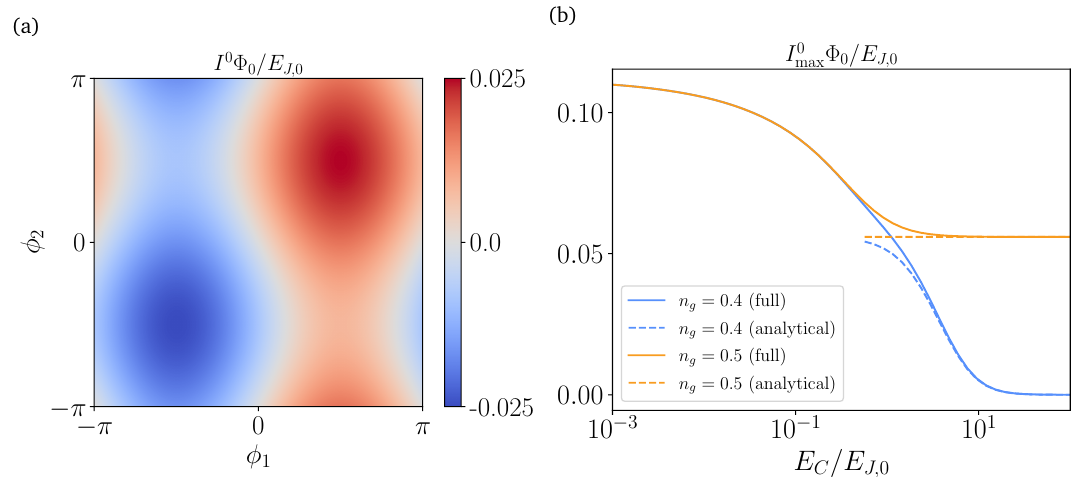
junction in the circuit of J ,0 = E / 2, E = E / 4, E = 30 E = 0. (b) critical , n J ,1 J ,0 J ,2 J ,0 C J ,0 g maximized over the average phase of 0 〈 I 0 ( φ ( 0 ) + V t , φ ( 0 ) − V t ) 〉 . When n = 1 / 2 charge + φ g 1 2 1 2 C